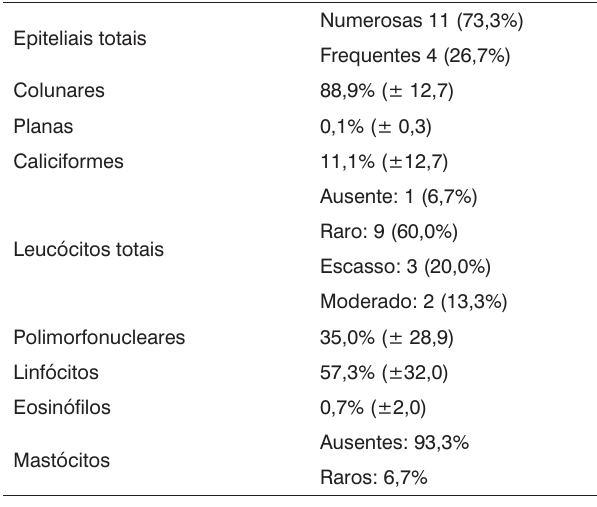
Tabela 5. Resultados encontrados no Citograma Nasal (CN).